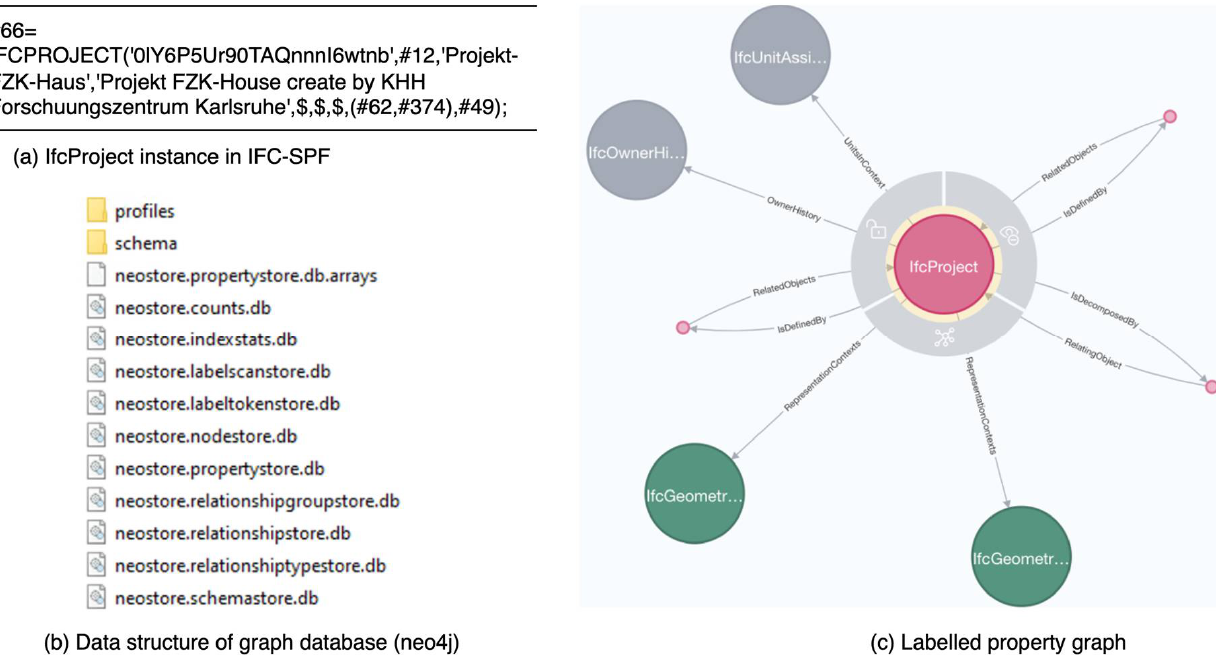
Figure 9. An example for the IFC-to-LPG conversion. ( a ) IfcProject instance in IFC-SPF, ( b ) data structure of graph database (neo4j), and ( c ) the LPG of the IfcProject